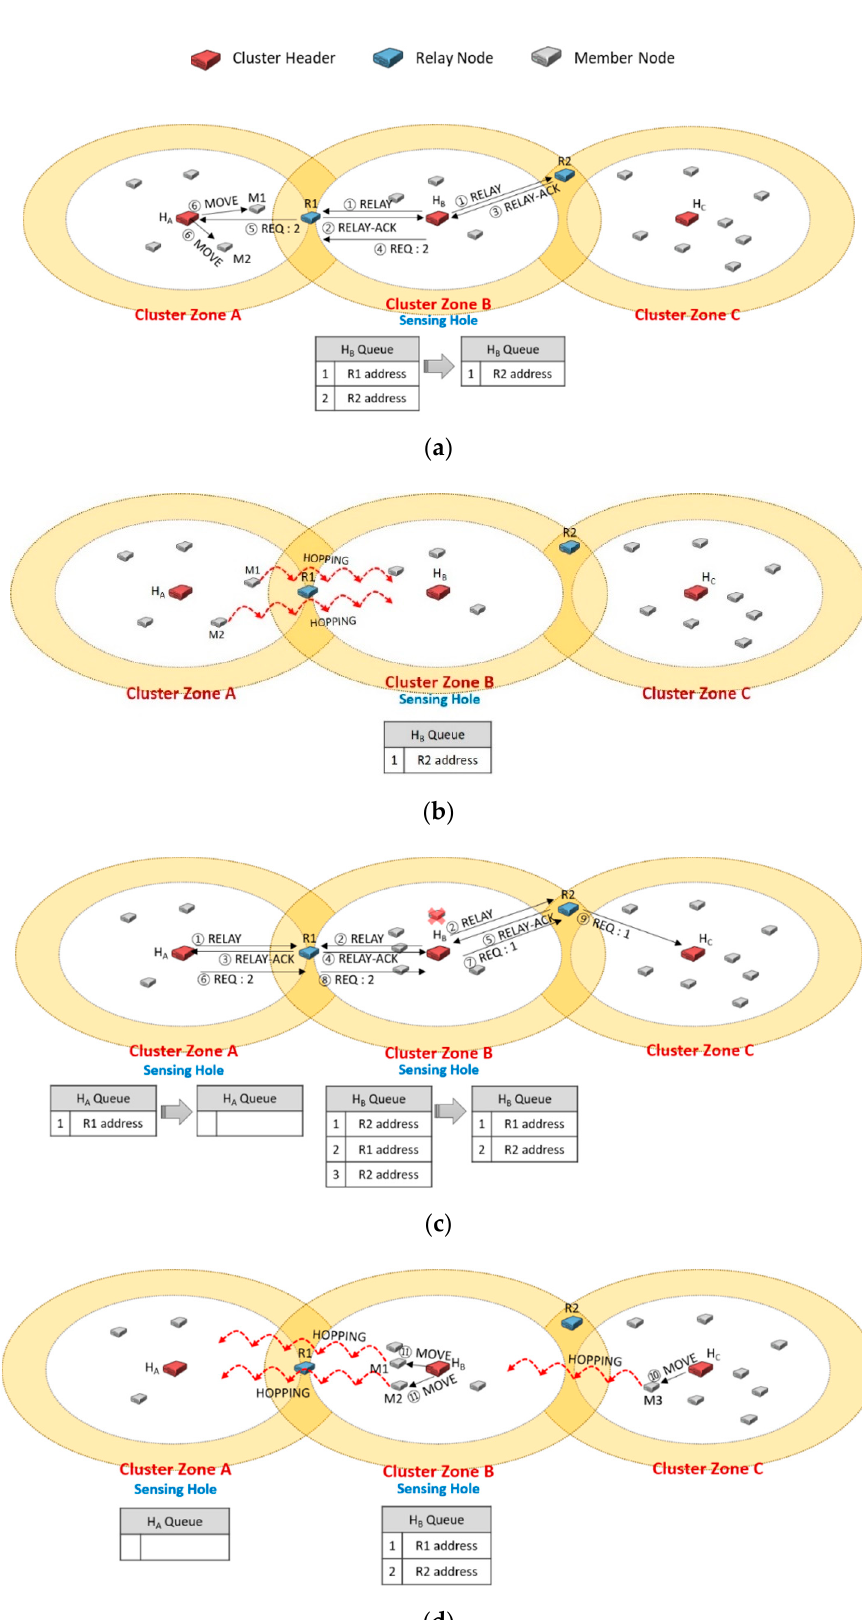
Figure 6. An example of using each header’s queue to manage the priority of selecting a relay node for ping-pong free.